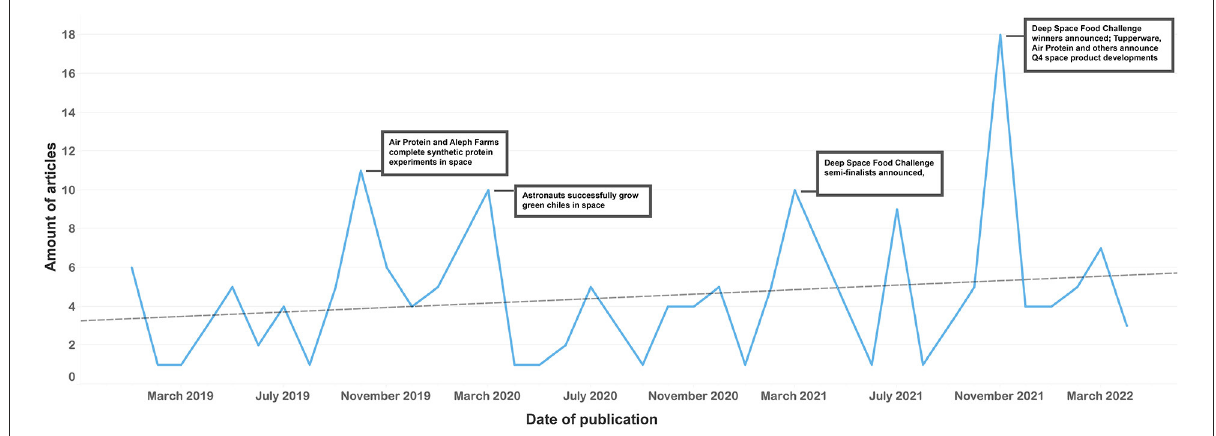
FIGURE1 The distribution of articles by date of publication, annotated at points of interest. A trend line shows a slight overall increase in coverage over the time period, although this increase is not statistically significant ( p =